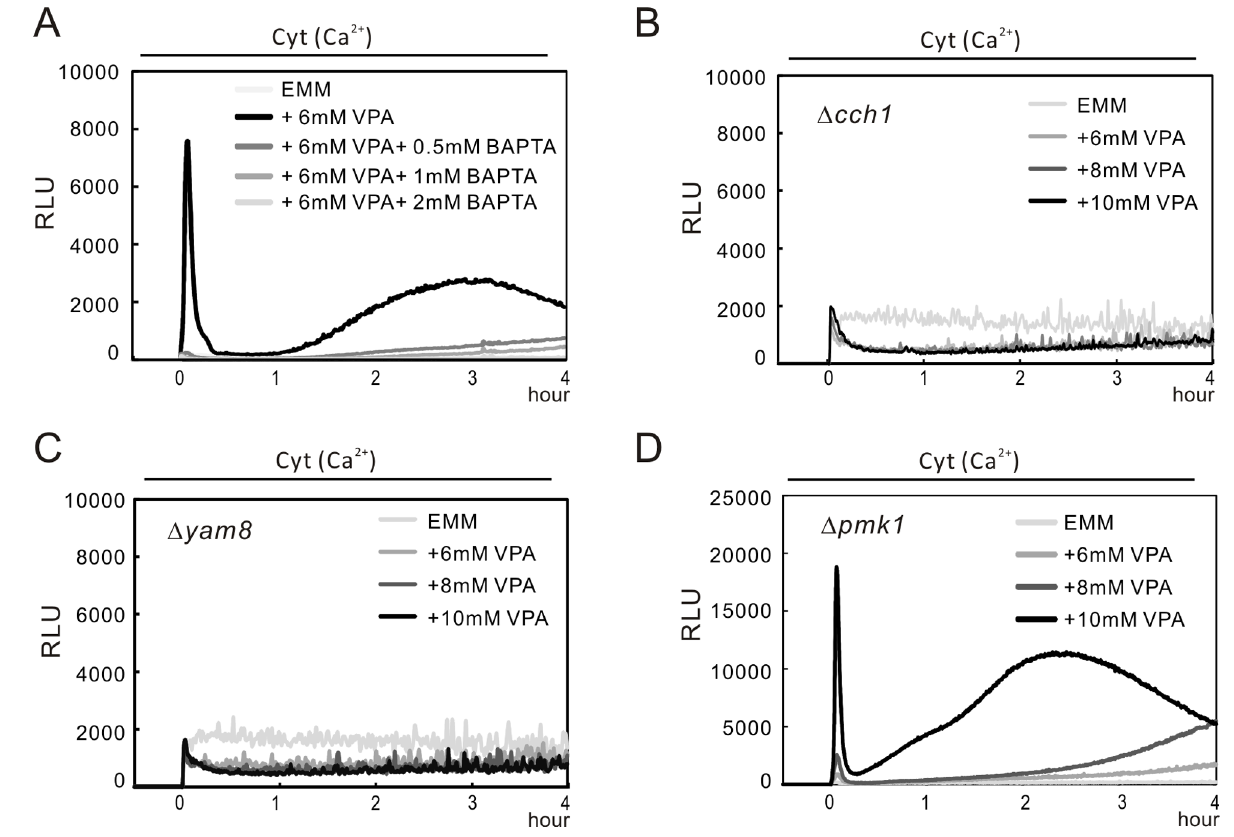
Figure 5. VPA triggers Ca 2 + influx via the Cch1-Yam8 channel complex. (A) The increase in the cytoplasmic Ca 2 + level is derived from the extracellular medium. The experiment was performed as described in Figure 4, expect that prior to the addition of 6 mM VPA, various concentrations of BAPTA (0.5, 1 and 2 mM) were added to chelate Ca 2 + in EMM medium. The data are representative of six independent experiments. (B) The cch1 deletion abolished VPA-induced Ca 2 + influx. The D cch1 cells harboring pKB6892 were cultured and assayed as described in the legend of Figure 4A. The data are representative of six independent experiments. (C) The yam8 deletion abolished VPA-induced Ca 2 + influx. The D yam8 cells harboring pKB6892 were cultured and assayed as described in the legend of Figure 4A. The data are representative of six independent experiments. (D)